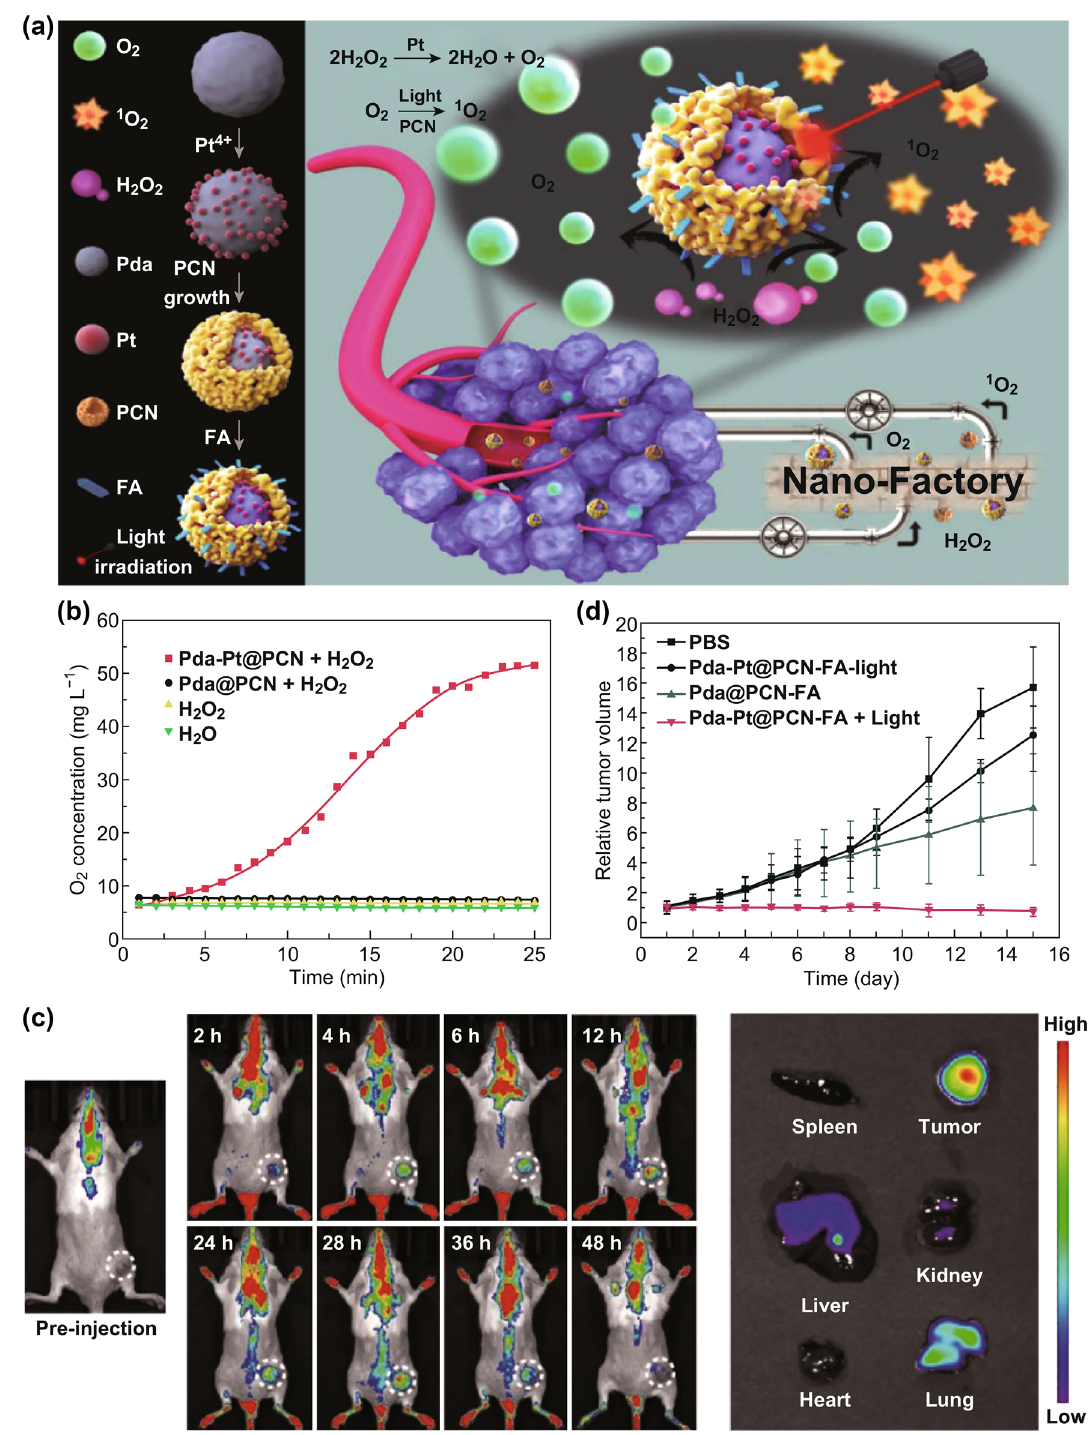
Fig. 5 a Schematic illustration of core–shell nanofactory for enhanced tumor therapy. Pda-Pt@PCN-FA converts H 2 O 2 from tumors into O 2 and 1 O 2 . b O 2 generation of different groups. c In vivo fluorescence images of Pda-Pt @ PCN-FA at different time after intravenous injection. d Tumor growth volume curves of different treated mouse group. Adapted with permission from Ref. [35]. Copyright 2018